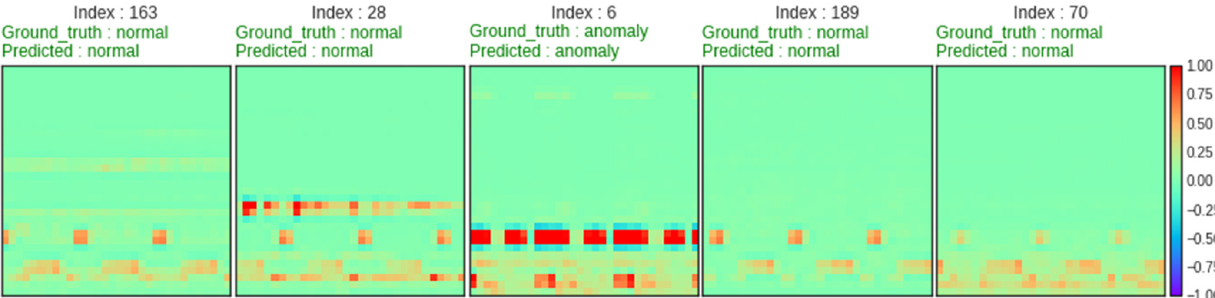
Figure 8. Slide rail data (4 K) STFT image encoding.